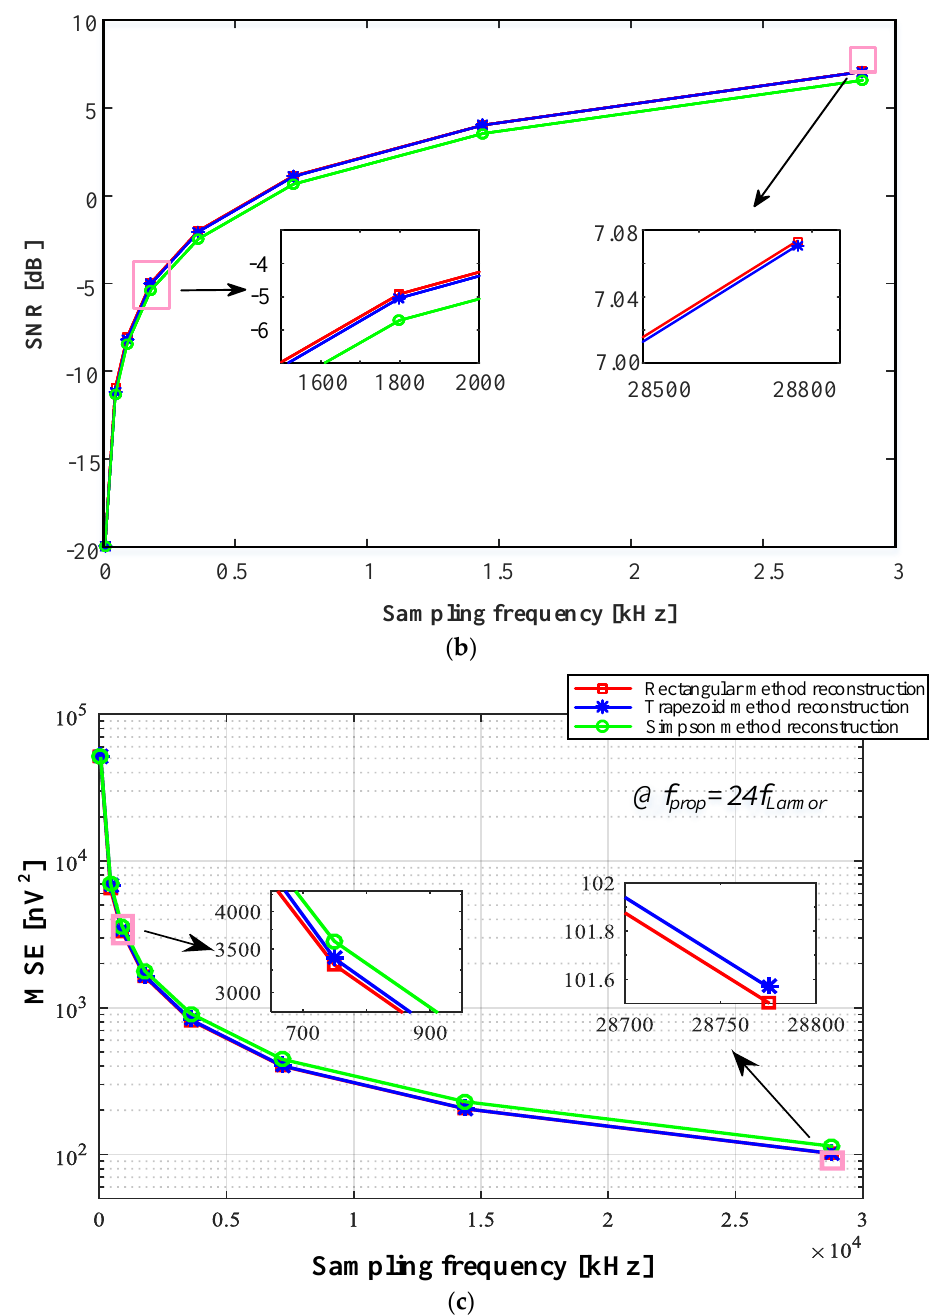
Figure 7. Comparison of three sparse reconstruction methods (rectangular sparse reconstruction, trapezoidal sparse reconstruction and Simpson sparse reconstruction): ( a ) SNR comparison, ( b ) SNIR comparison, ( c ) MSE comparison.